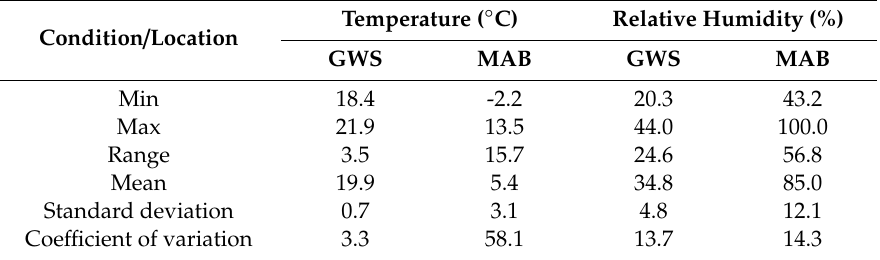
Figure 2. Ambient temperature changes during wires storage—Gdańsk welding site (GWS) and Mońki agricultural building (MAB)—1 month. Table 3. Values of statistical measures and coe ffi cients describing changes in storage